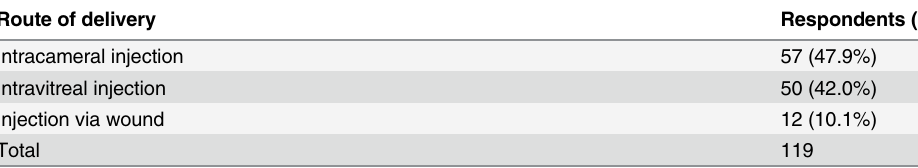
Table 3. Intraocular route of antibiotic agents delivery in open globe